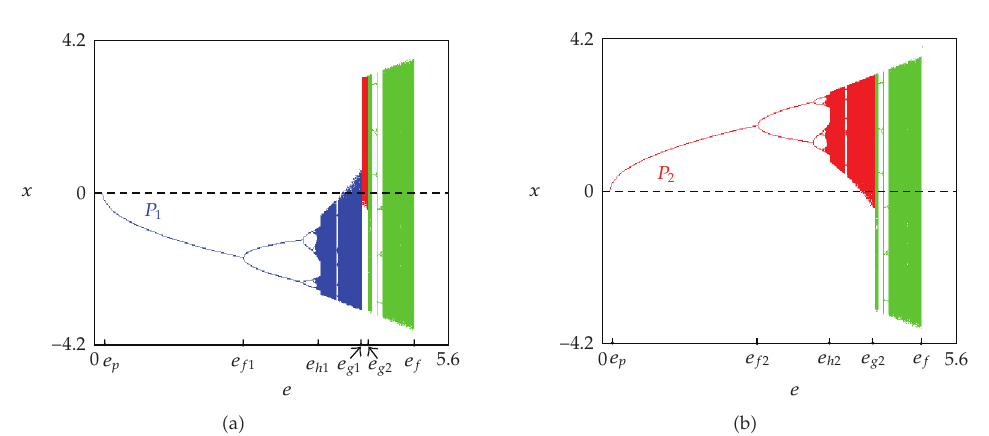
Figure 15: Bifurcation diagram of the dynamic behavior of x as a function of the parameter e , in the three- dimensional model, at the other parameter values given in the text (cid:5) Section 5 (cid:6) . Pitchfork bifurcation of the fundamental O at e p (cid:4) 0 . 122 . Flip bifurcation of P 1 at e f 1 (cid:4) 2 . 348 , flip bifurcation of P 2 at e f 2 (cid:4) 2 . 457 . First homoclinic bifurcation of P 1 e h 1 (cid:4) 3 . 565 , first homoclinic bifurcation of P 2 at e h 2 (cid:4) 3 . 6 . Global bifurcation causing the disappearance of the chaotic set with P 1 at e g 1 (cid:4) 4 . 215 , global bifurcation causing the explosion to a wide chaotic set at e g 2 (cid:4) 4 . 323 . Final bifurcation at e f (cid:4) 5 . 06